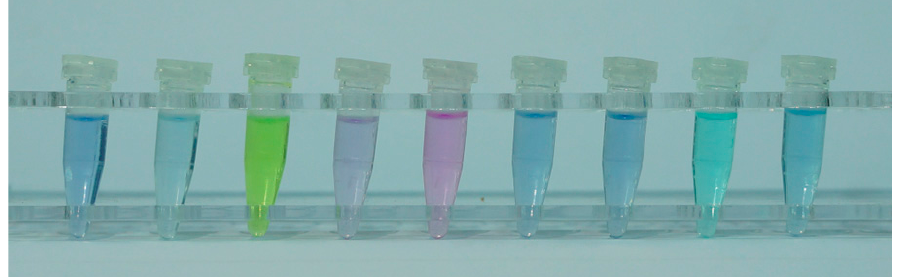
Figure 4. The color changes in the colorimetric solution before and after the addition of different interferents. From left to right, blank, 50 μ g/mL of VX, and 4 mg/mL of parathion, DDVP, DCP, DMMP, toluene, AcOH, and Et 3 N.